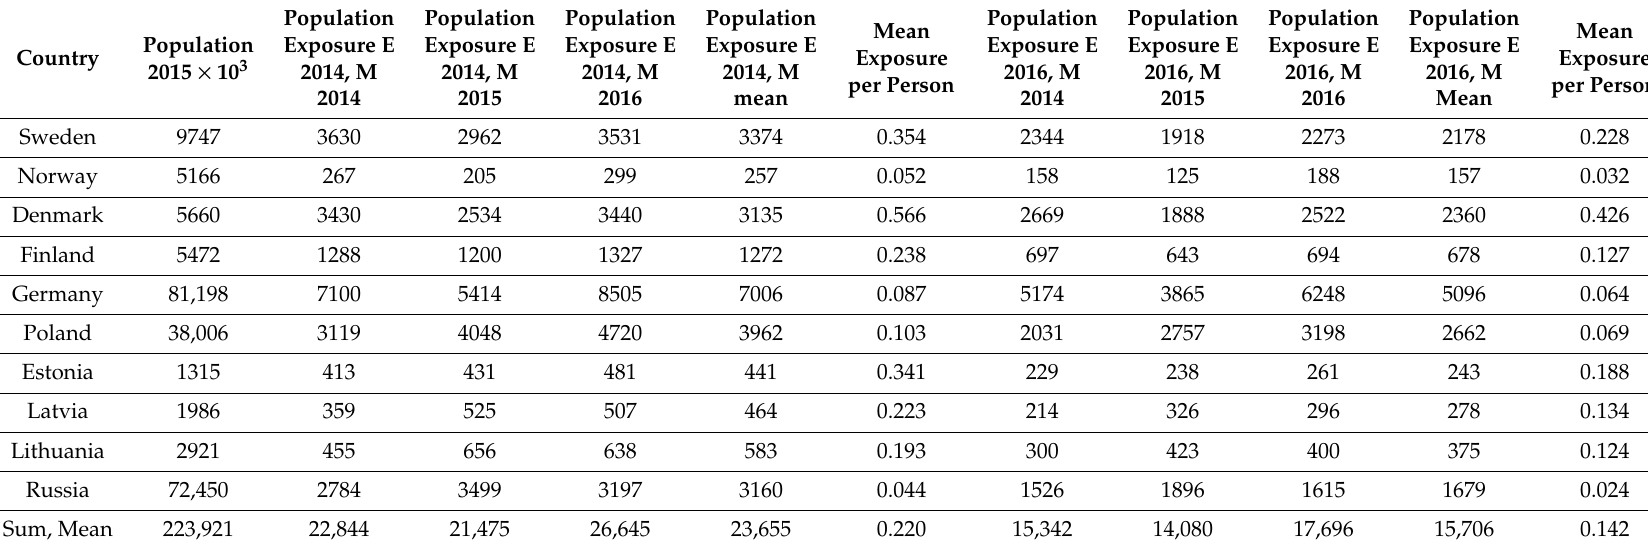
Table 1. Population exposure of PM 2.5 (in µ g / m 3 × number of persons × 106) and mean exposure per inhabitant from contributions of Baltic shipping to ambient PM 2.5 concentrations in ten European countries. The table shows emissions (“E”) in 2014 (before SECA) and 2016 (after SECA) under meteorological conditions (“M”) in 2014, 2015, and 2016. The numbers for Russia only considers the European part of